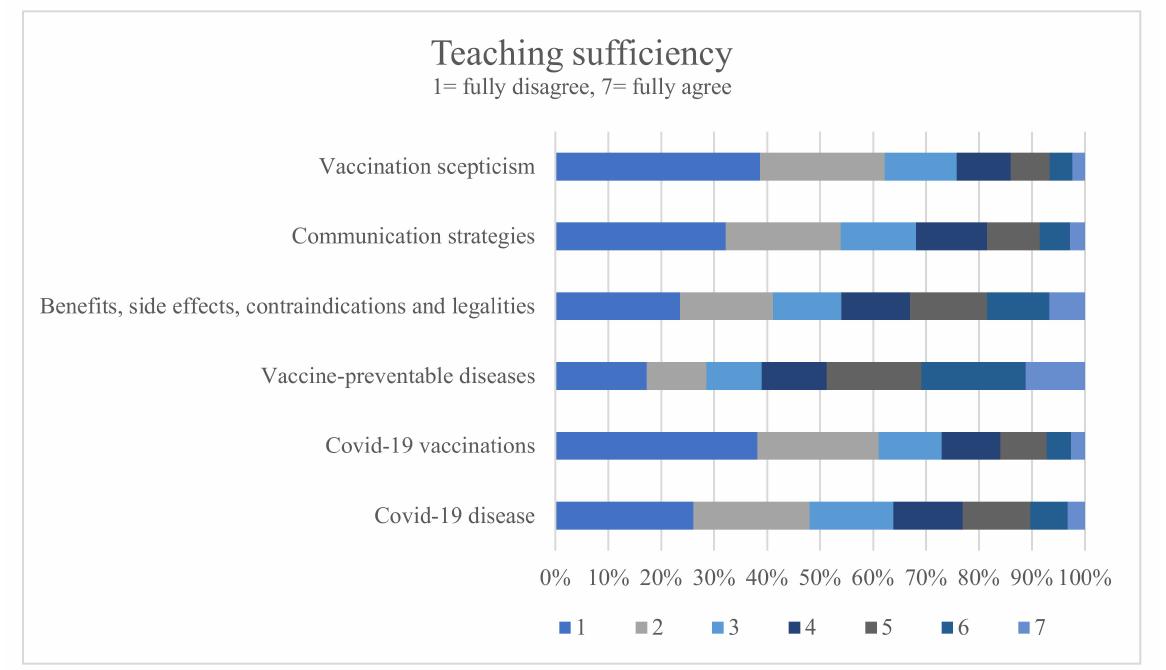
Figure 2. Percentage agreement to statements regarding teaching of vaccination-related